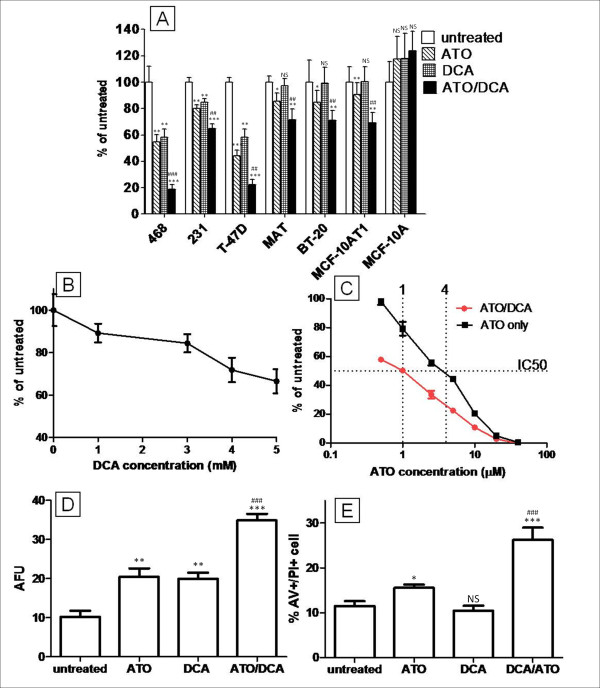
Inhibition of cancer cell growth by ATO and DCA. (A) Combined effect of ATO (5 or 15 μM) and DCA (5 mM) on breast cancer cell growth as measured by neutral red viability assay after 3 days of treatment. BT-20, T-47D, MDA-MB-468 and MCF-10AT1 cells were treated with 5 μM ATO. MDA-MB-231, MAT and MCF-10A cells were treated with 15 μM ATO. (B) Dose response of T-47D cells towards DCA (t = 72 hours). (C) Dose response of T-47D cells towards ATO and ATO/DCA (5 mM) treatment (t = 72 hours). (D) T-47D proliferation measured as mean CFSE intensity after treatment with 5 μM ATO and/or 5 mM DCA (t = 72 hours) (higher CFSE intensity indicating less proliferation). (E) Cell death (AV+/PI+) population expressed as percentage of total cell number after 48 hours of treatment with 20 μM ATO and/or 5 mM DCA. * P ≤ 0.05, ** P ≤ 0.001, *** P ≤ 0.0001, NS - not significant (treated vs untreated). ## P ≤ 0.001, ### P ≤ 0.0001 (ATO/DCA vs ATO).